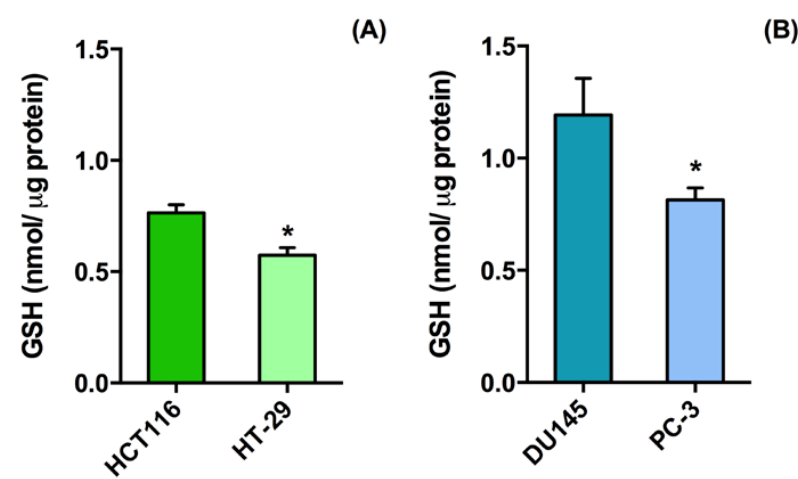
Figure 1. Intracellular glutathione-responsive β -cyclodextrin (GSH) level according to cell type. The reduced glutathione content of human colorectal cancer cell lines, HCT 116 and HT-29 ( A ), and human prostatic carcinoma cell lines, DU145 and PC-3 ( B ), was measured at a basal level, that is, in untreated cells, and was expressed as nmol / µ g protein. The results are mean values ± SD of three independent experiments performed in triplicate. Statistically significant difference between cell lines: * p < 0.05. Table 2. Glutathione-responsive β -cyclodextrin-based nanosponge (GSH-NS) inhibition concentration (IC) values on 2D cell cultures.